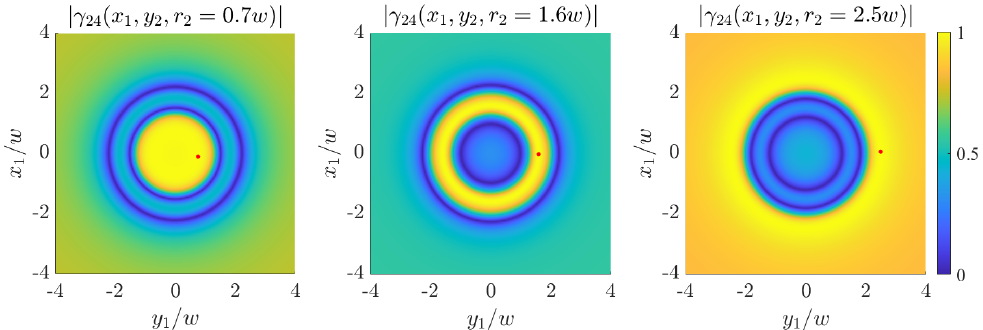
Figure 5. Absolute degree of coherence (Equation (40)) relative to three different points, indicated by red dots, for N = 2, m =